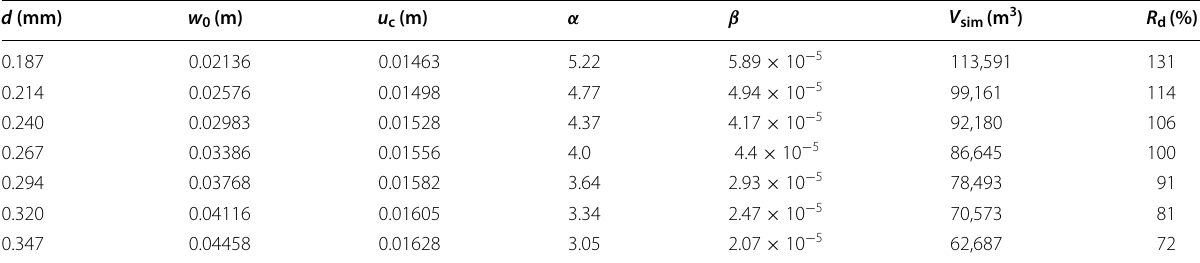
d , Grain size; w 0 , Settling velocity in the static water column; u c , Critical shear velocity; α , Empirical parameter for the bedload formula; β , Empirical parameter for the exchange rate formula; V sim , Volume of resampled and interpolated deposit around Suijin-numa; R d , Ratio of deposition volume to the reference ( d = 0.267 mm